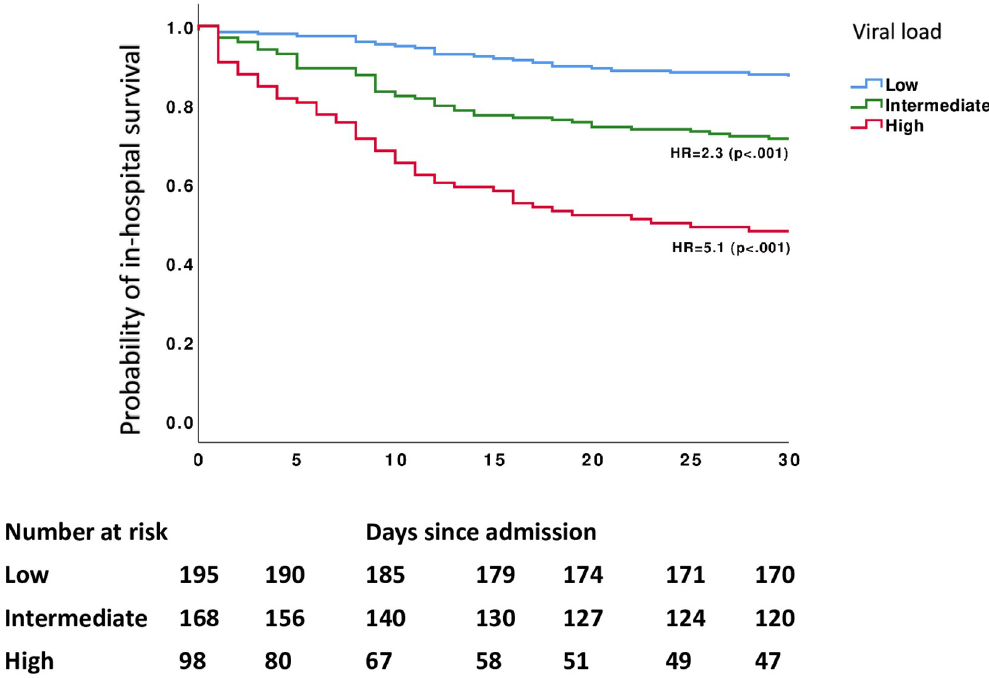
Fig 3. Probability of in-hospital survival in patients with SARS-CoV-2 infection stratified by initial viral load